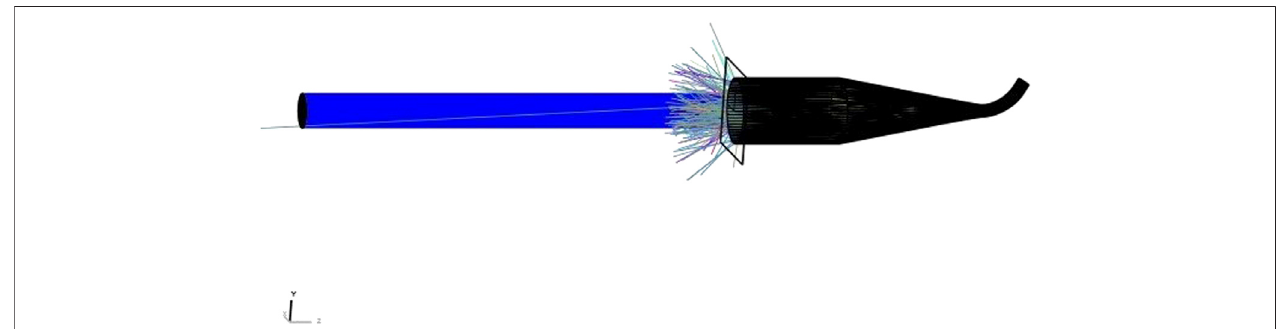
FIGURE 2 | Schematic overview of NSC 3D-Layout simulated in Zemax OpticStudio.